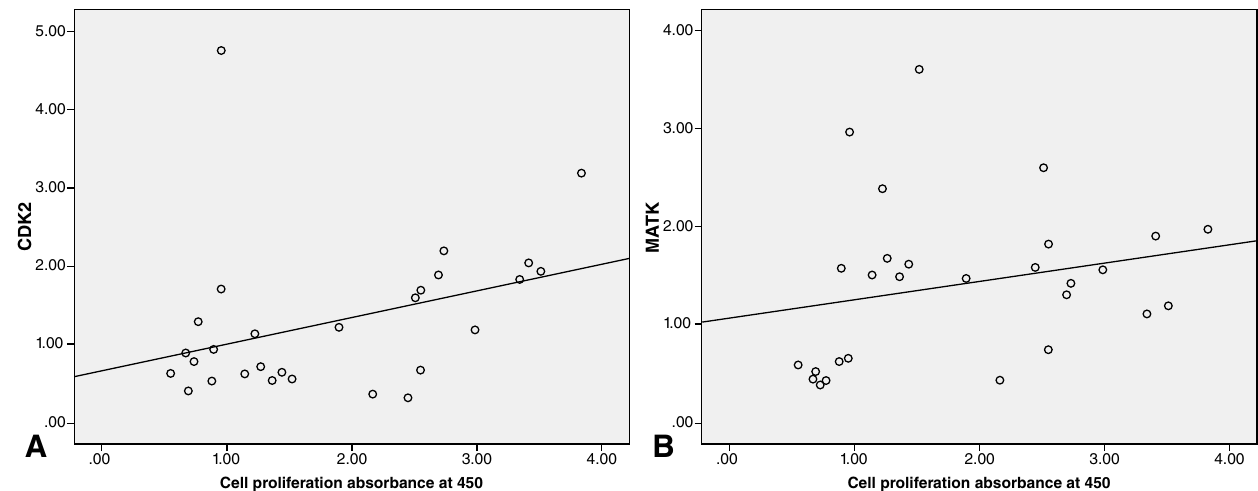
Figure 4. Assessment of cell proliferation. ( A ) Expression of CDK2 is positively correlated with cell proliferation in the test group. (P=0.010) (r=0.480). ( B ) Expression of MATK is positively correlated with cell proliferation in the test group (P=0.031) (r=0.409).